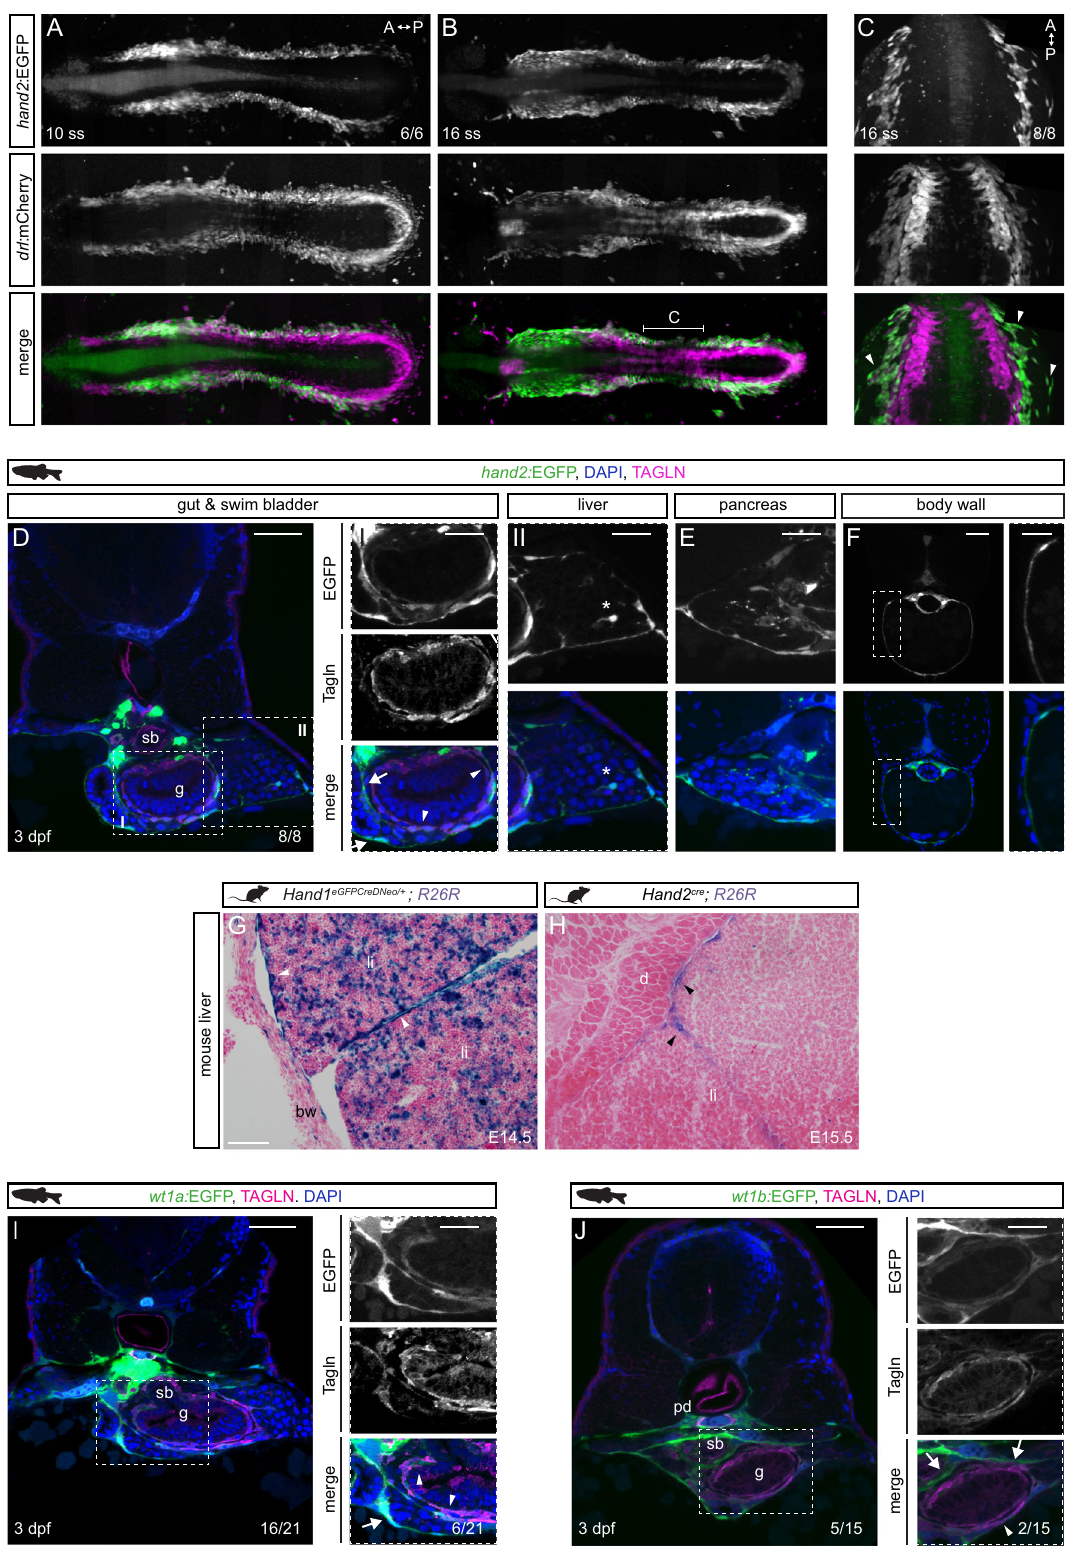
(Fig. 4E, F), with the developing gut located medially between the PGC clusters 114 . These observations further support our con- clusion that the PGCs migrate in close association with the forming coelomic epithelium, as marked by hand2 expression, already during early development. The functional importance of